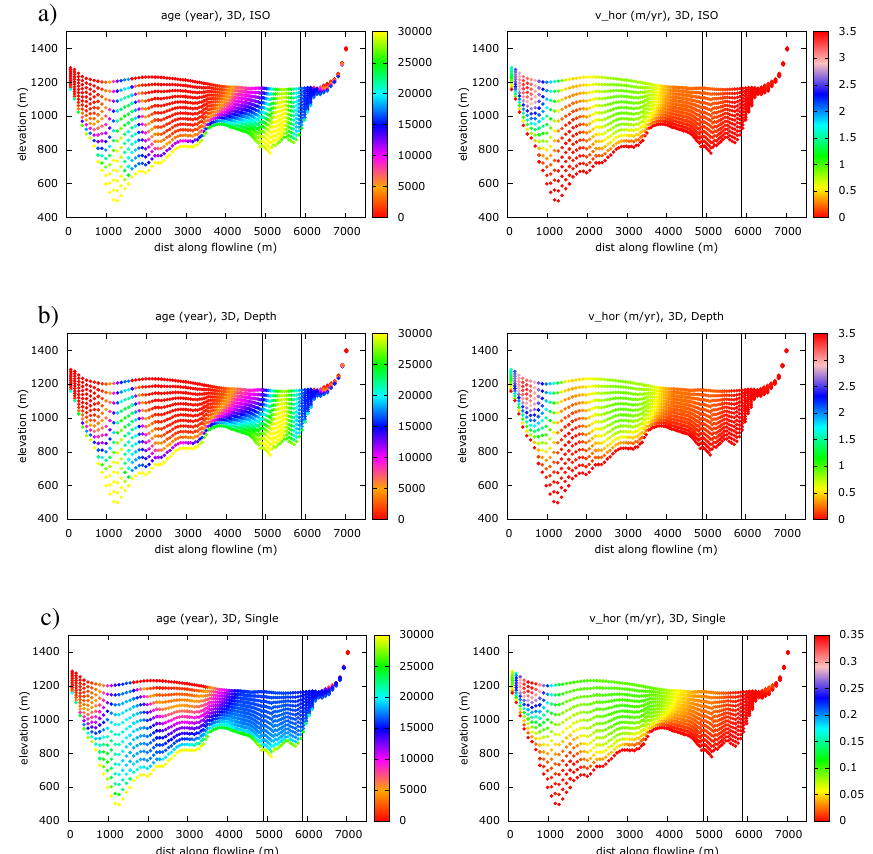
Fig. 6. Comparison of age (left column) and velocity (right column) values obtained on the flow line (red line shown in Fig. 1) with the three-dimensional model using (a) isotropic Glen’s flow law, (b) depth-dependent fabric and (c) single maximum fabric distribution (note: one order of magnitude lower velocities). Age values are computed applying an integration over 15kyr. The two vertical lines mark the intersection with the horizontal ice core at points V and H.